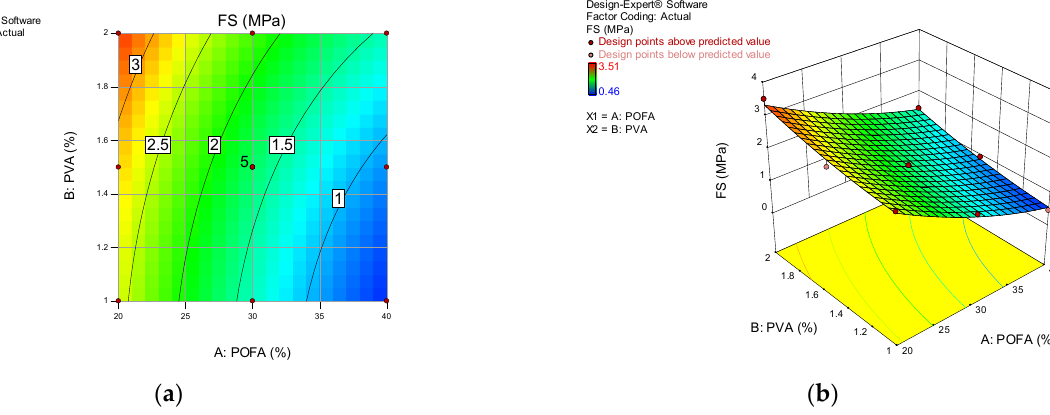
( b ) Figure 23. ( a ) 2D Contour Plot and ( b ) 3D Response Surface Diagram for Tensile Strain Capacity. 4.2. Multi-Objective Optimization An effort at optimizing the system is made to discover what values of the independ- ent variables should be used to attain the highest possible level of the response of interest. Attaining the objective function may be completed by creating objectives for the variables (input factors and responses) that have various criteria and degrees of relevance. When evaluating the optimization, the desirability value, which ranges from 0 to 1, is used. The closer the value is to one, the more favourable the result [28].